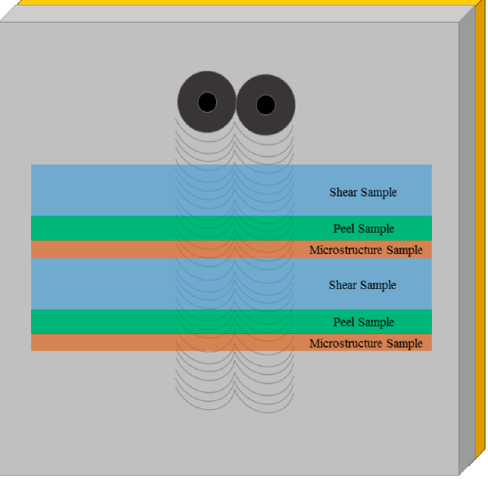
Figure 3. Schematic diagram of sample cutting for shear, peel and microstructure analysis.